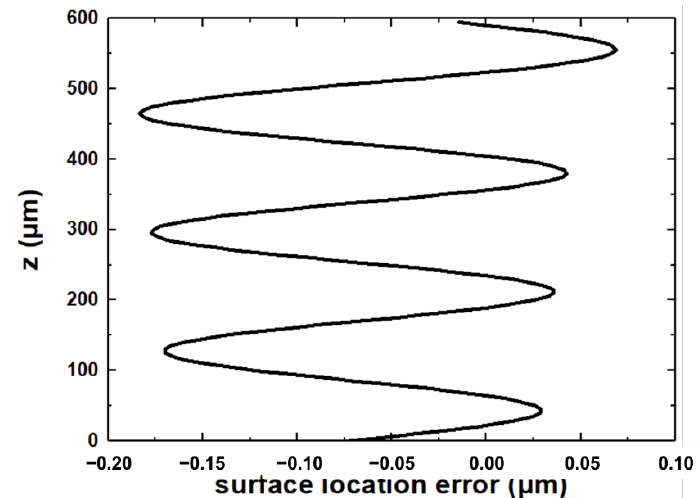
Figure 10. Surface location error variation with axial length.